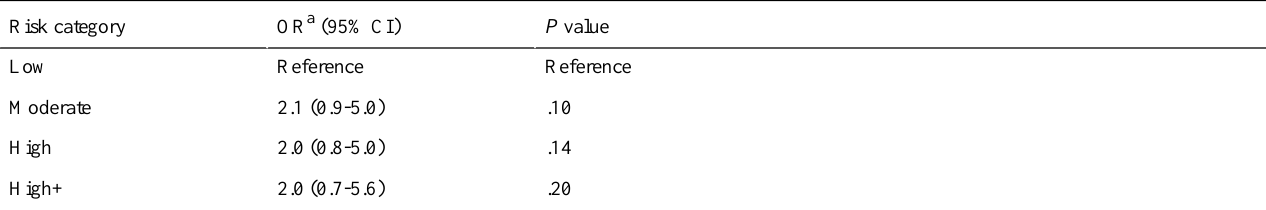
Table 3. Generalized estimating equations analysis of the influence of the UDT Randomizer risk category on the consistency of drug testing with the prescribed opioid